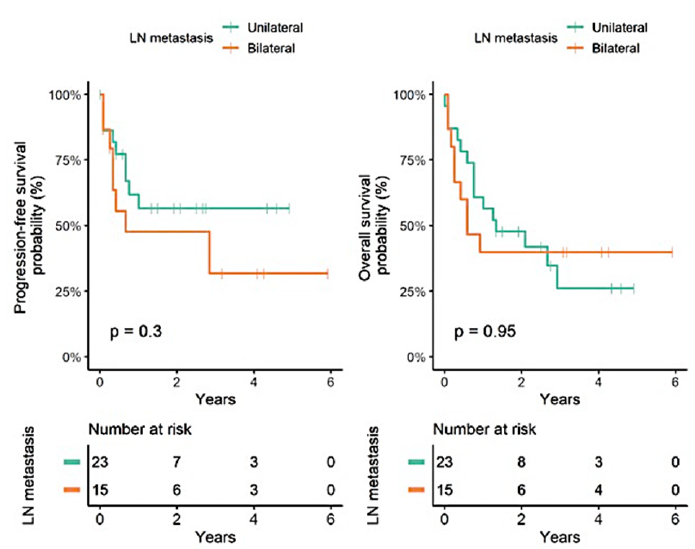
Figure 7. Survival analysis for unilateral or bilateral pelvic lymph node metastasis.